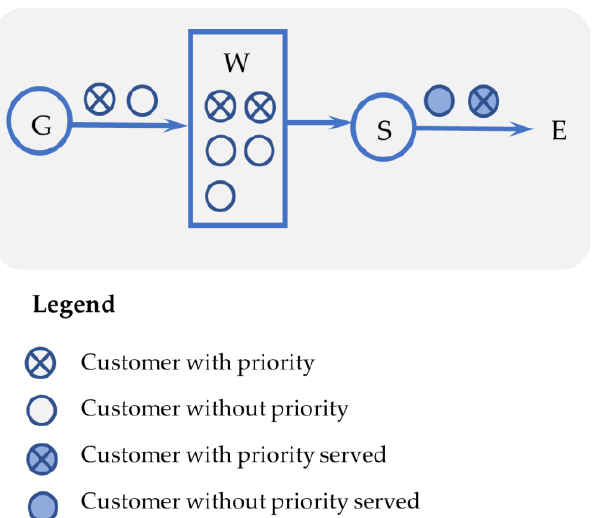
Figure 1. Single server, service without interruption.